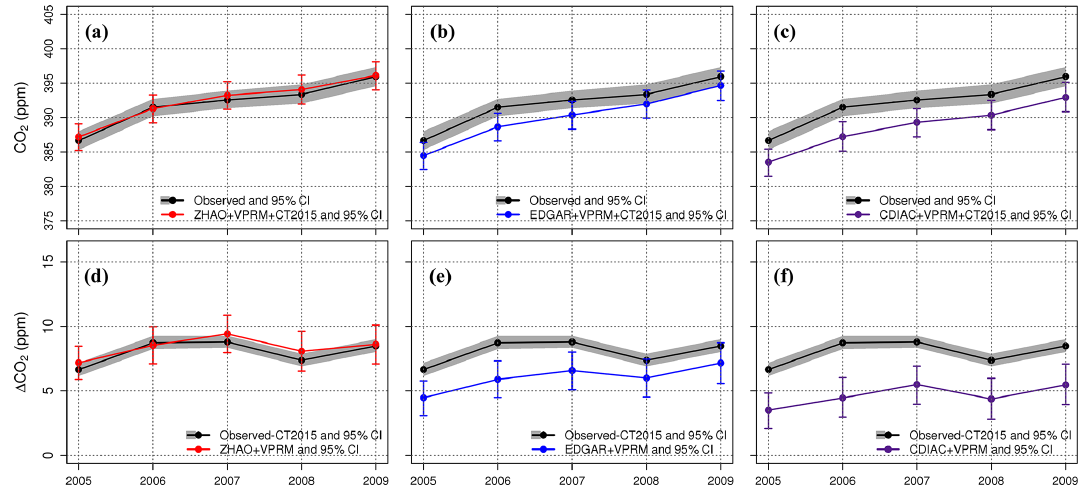
Figure 6. Mean annual CO 2 and (cid:49) CO 2 over the entire study time period. (a–c) CO 2 annual concentration; (d–f) (cid:49) CO 2 (regional enhance- ment, after removal of advected CT2015 background) with bootstrapped 95% confidence